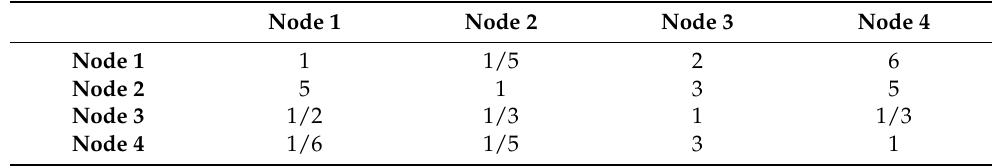
Table A2. Pairwise comparison matrix for No. hops criterion.